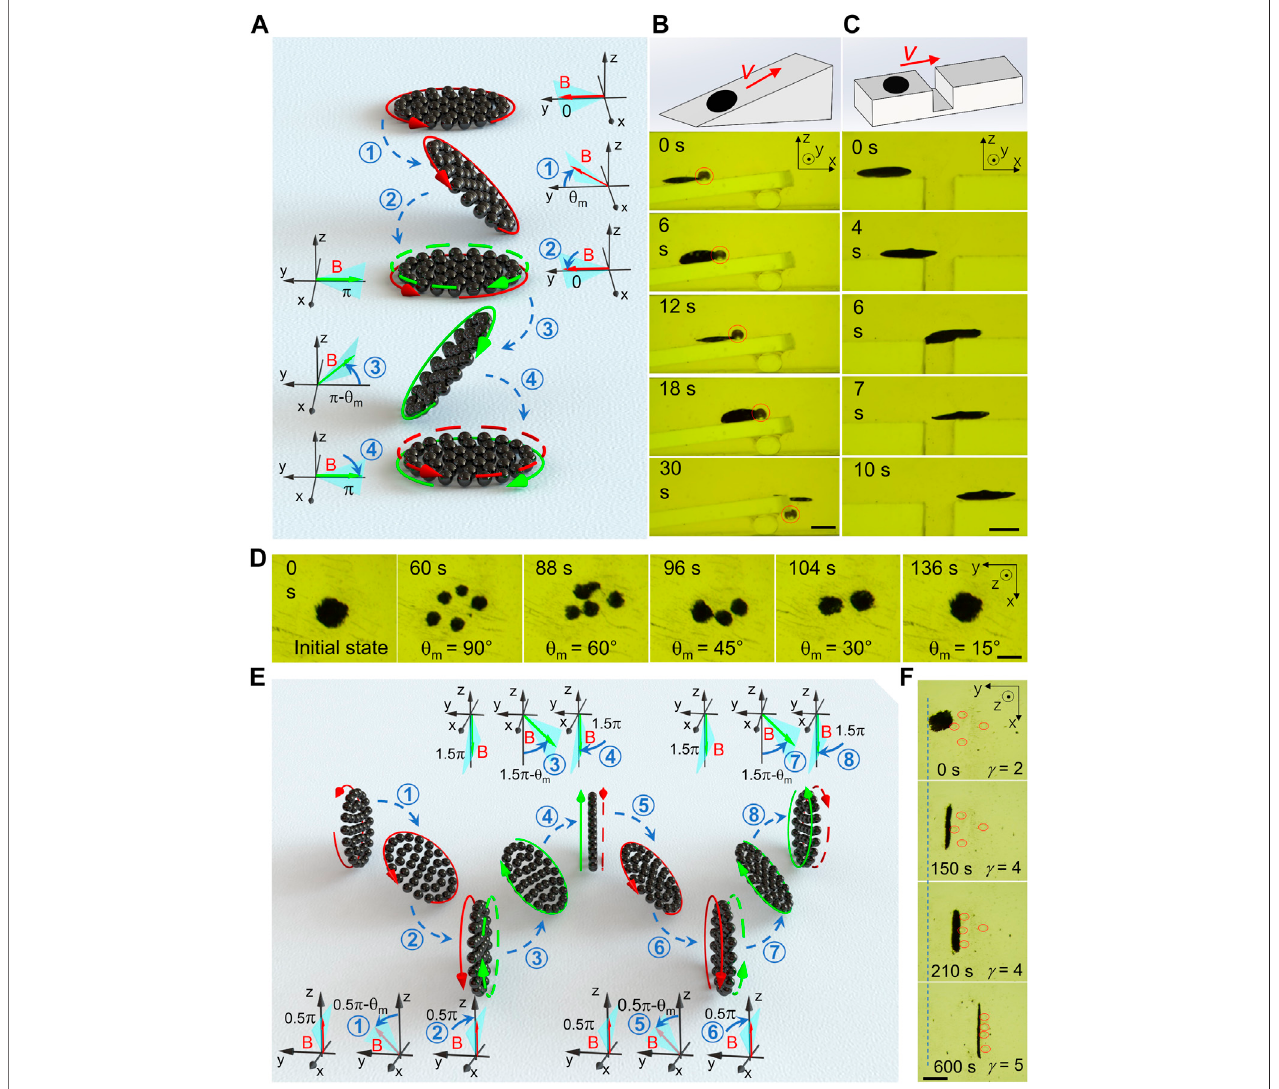
FIGURE 6 | Biomimetic swarms from fi n motion of fi sh. (A) Schematic propulsion principle of a wheel-like swarm with paired- fi n swimming gait. Like “ paired fi n ” swimming, the magnetic- fi eld plane swings alternately in the positive y -axis direction and the negative y -axis direction. (B) Transportation of a bead on the slope using a wheel-likeswarminpaired- fi nmotionmode.Thescalebaris1.8 mm. (C) Demonstrationofoperatinga fi n-likeswarmtostrideacrossacrevasse.Thescalebaris2 mm. (D) Splitting and reversible merging of dynamic swarm with cross-paired- fi n swimming gait. In “ cross-paired- fi n ” motion mode, the magnetic- fi eld plane swings alternatelyinthepositive x -axisdirection,thepositive y -axisdirection,thenegative x -axisdirectionandthenegative y -axisdirection.Thescalebaris1 mm. (E) Schematic propulsion principle of a wheel-like swarm with caudal- fi n swimming gait. Like “ caudal fi n ” swimming, the magnetic- fi eld plane swings alternately in the positive z -axis direction and the negative z -axis direction. (F) Collecting of multiple beads using a recon fi gurable wheel-like swarm in caudal- fi n motion mode. The scale bar is 1 mm.